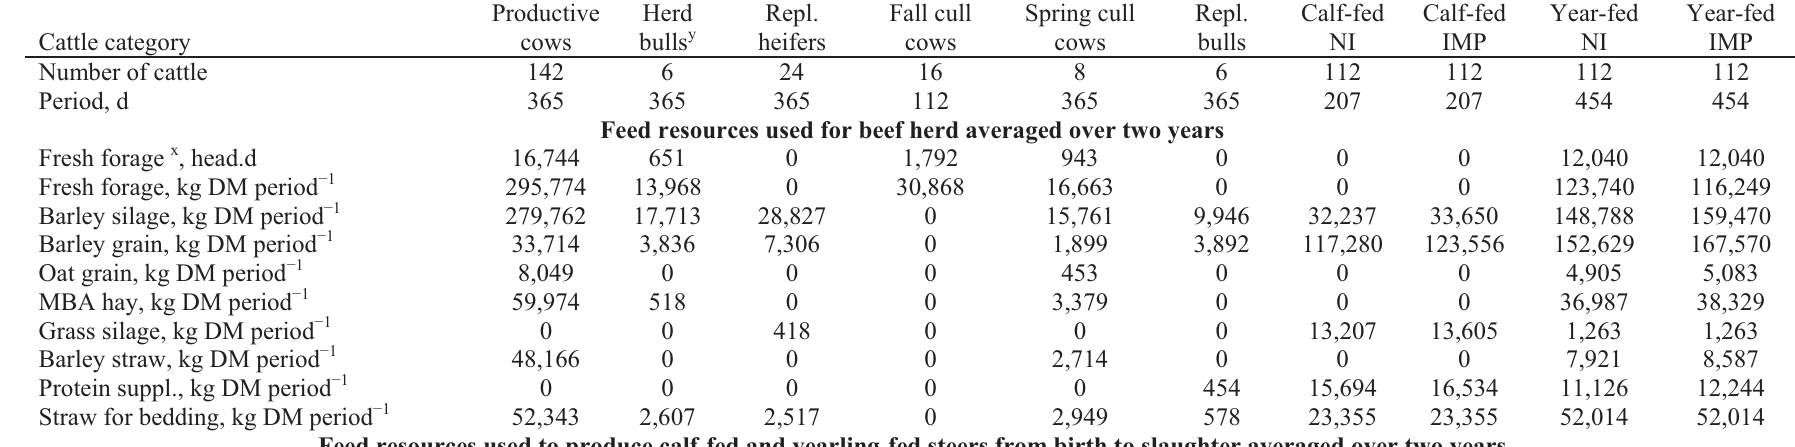
MBA hay, kg DM period (cid:2)1 48,166 Feed resources used to produce calf-fed and yearling-fed steers from birth to slaughter averaged over two years Total fresh forage x ,